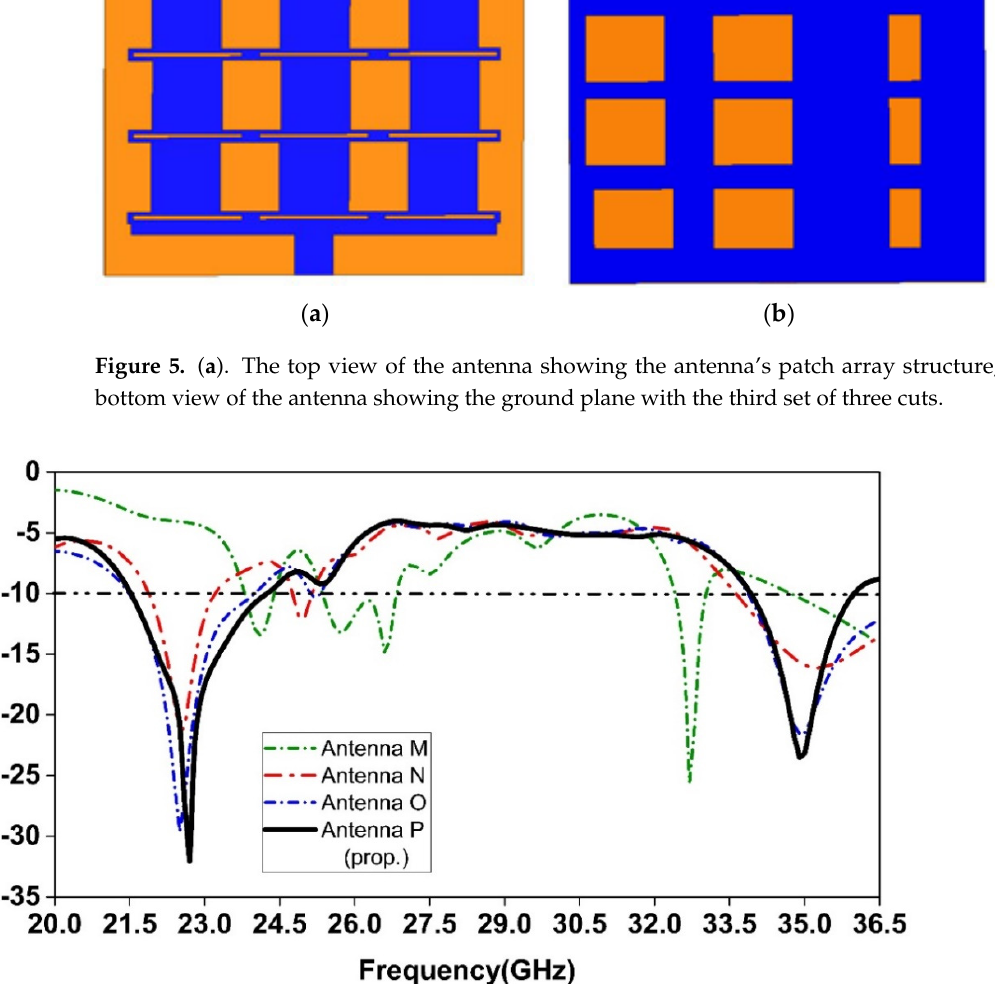
Figure 6. Variation in reflection coefficient with frequency for different antenna configurations.